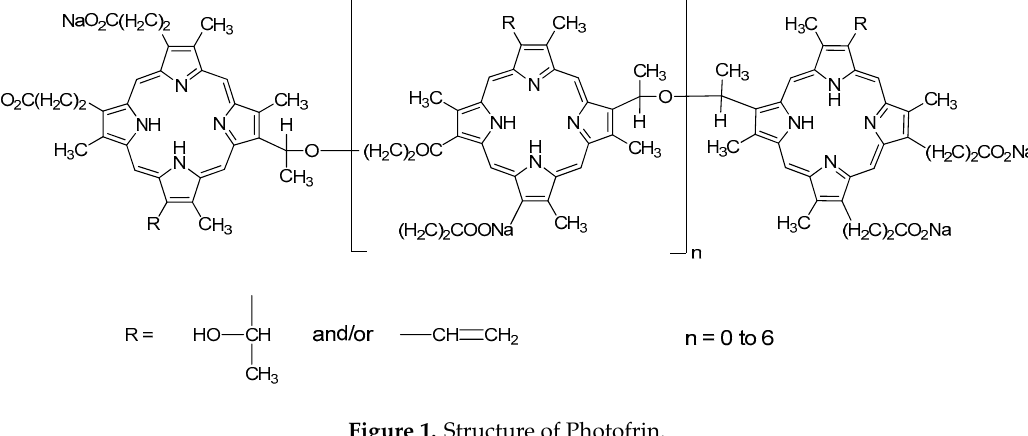
Figure 1. Structure of Photofrin.